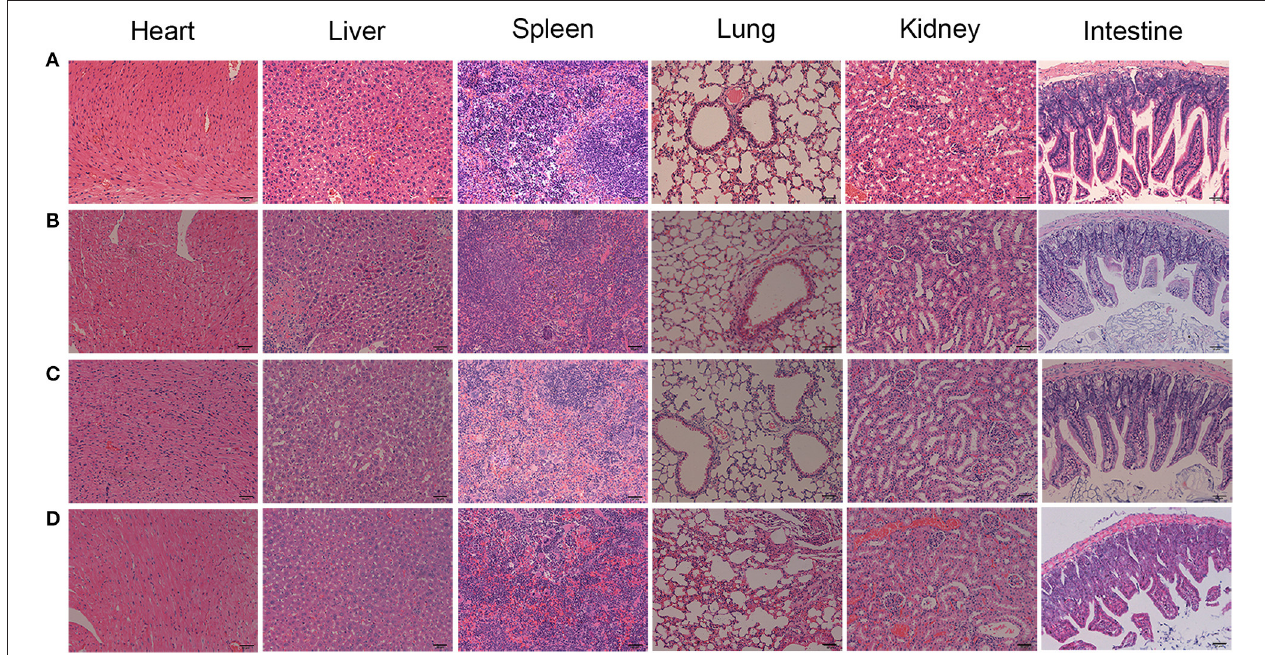
FIGURE 10 | H&E stained organs from the A549 tumor-bearing mice with different treatments. (A) PBS; (B) HA; (C) HA-CMC-PLGA NPs; (D) TF-CMC-PLGA-HA NPs. Scale bar = 50 µ